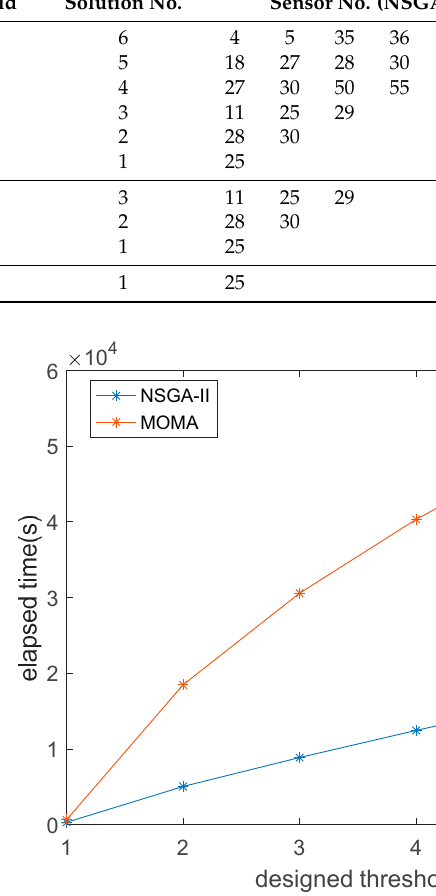
Figure 6. Elapsed time of (non-dominated sorting genetic algorithm) NSGA-II and multi-objective optimization monkey algorithm (MOMA) for the different designed thresholds of sensor number.